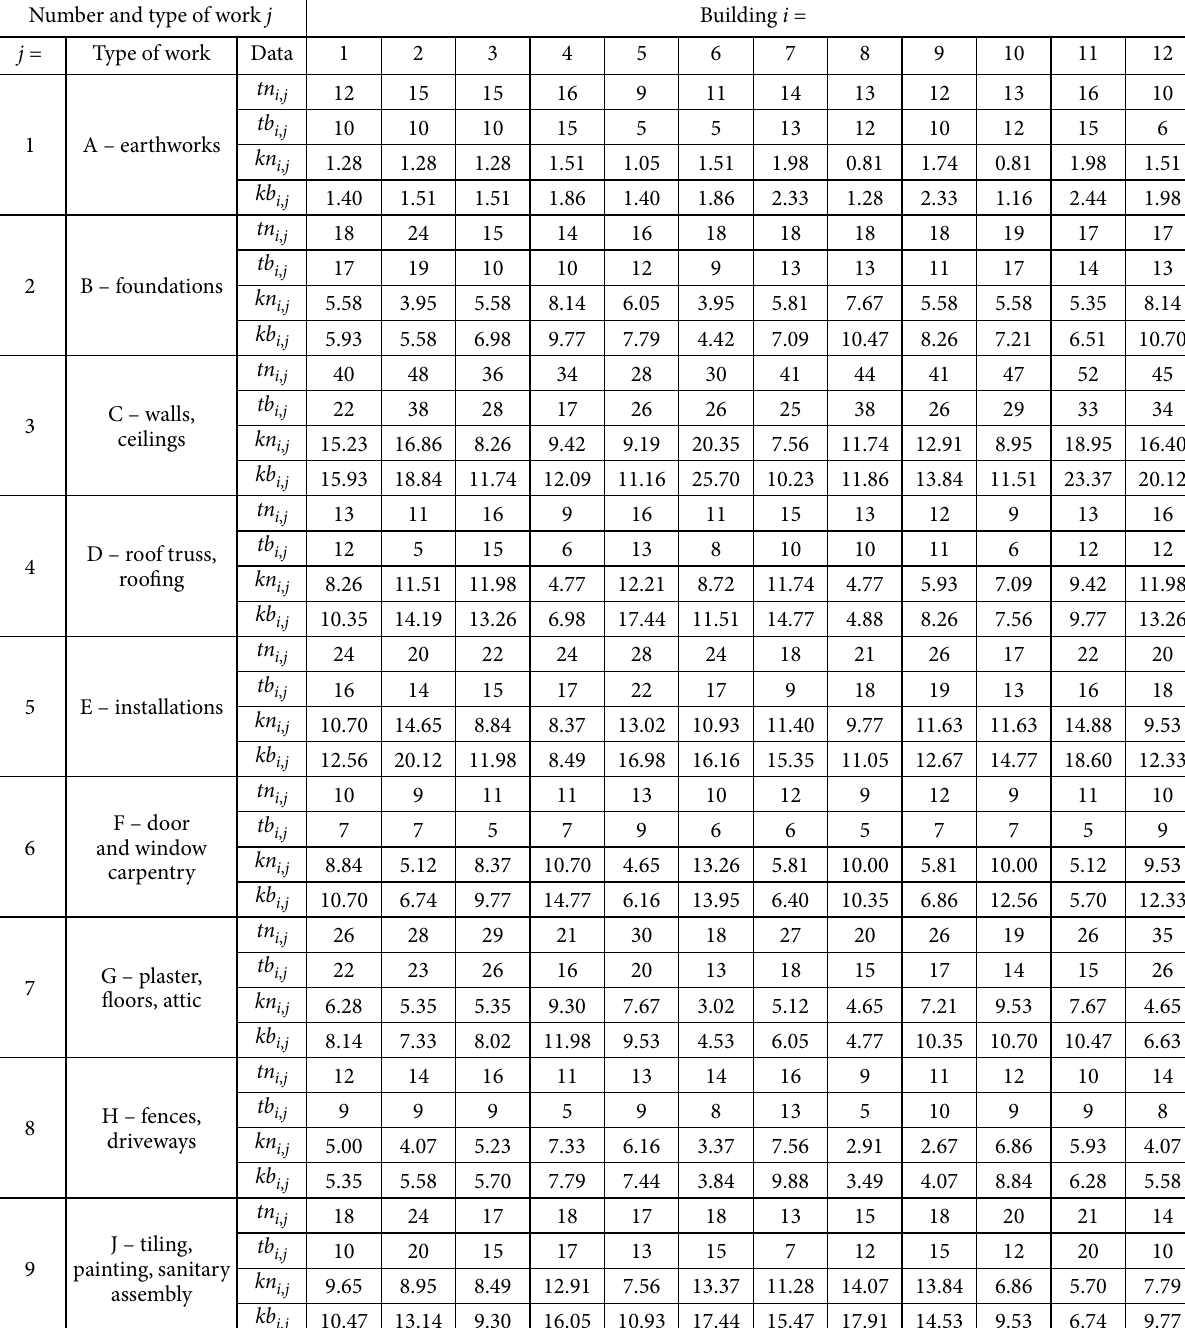
Table 2. Ranges of execution times and costs of works in n = 12 residential buildings for m = 9 works. Units: for tn i , j and tb i , j – working days; for kn i , j and kb i , j – thousand